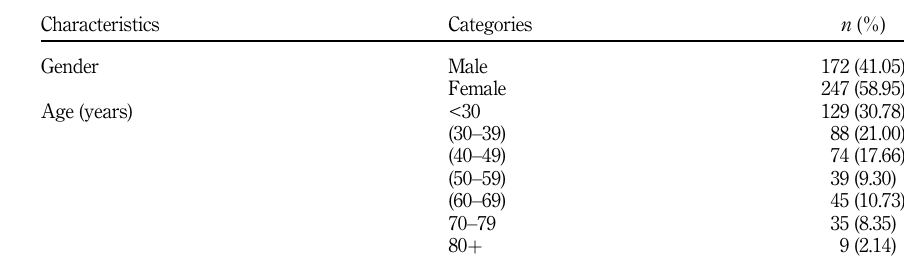
characteristics of patients ( n 5